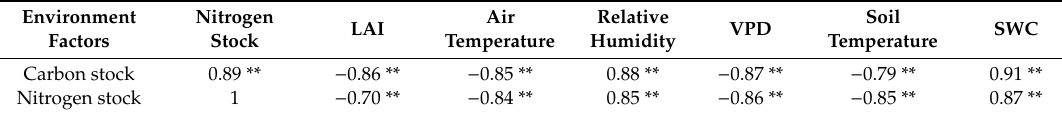
Table 13. Correlation matrix of the ecosystem carbon and nitrogen stocks and environmental factors in the larch